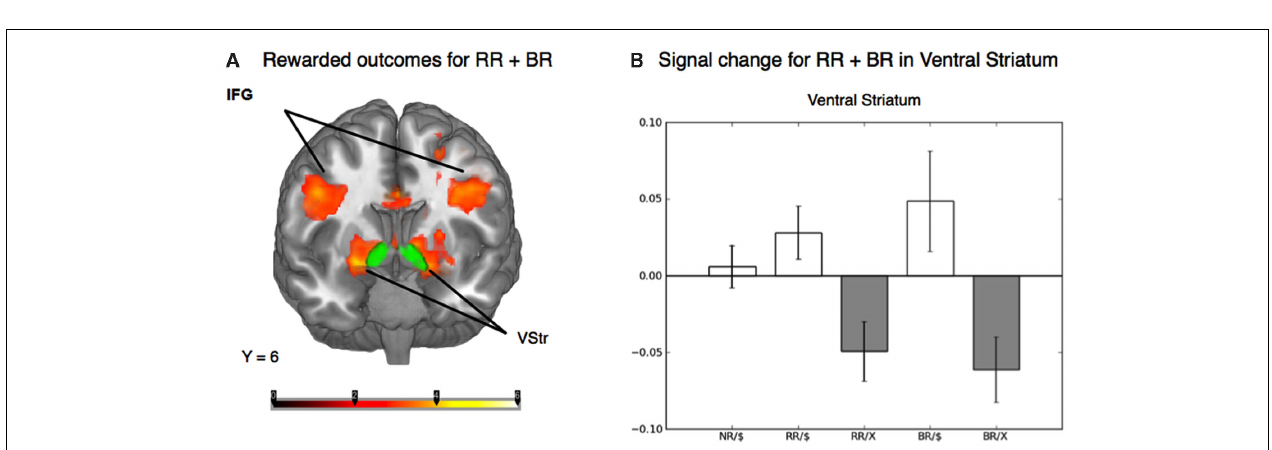
nucleus accumbens was based on the standard ROI for the nucleus accumbens subcortical region as defined by the Harvard-Oxford atlas within FSL and is shown in green. (B) Mean percent signal change extracted from an anatomically defined ROI in theVstr. Mean percent signal change (SE) is plotted for rewarded no risk (NR), reward risk (RR), and behavioral risk (BR) outcomes, as well as unrewarded reward risk and behavioral risk